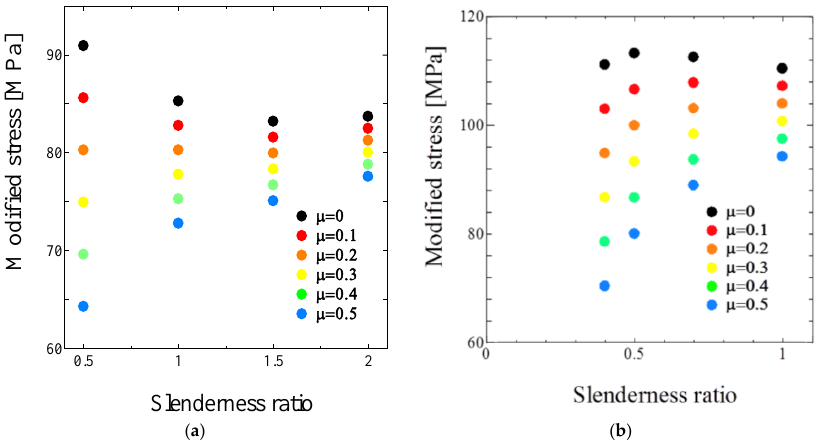
Figure 6. The relationship between modified stress calculated by Equation (9) for each friction coefficient and slenderness ratio obtained by ( a ) quasi-static and ( b ) impact tests using an annealed specimen. Table 1. The material parameters of the models by Allen et al. [14], determined by experimental results.